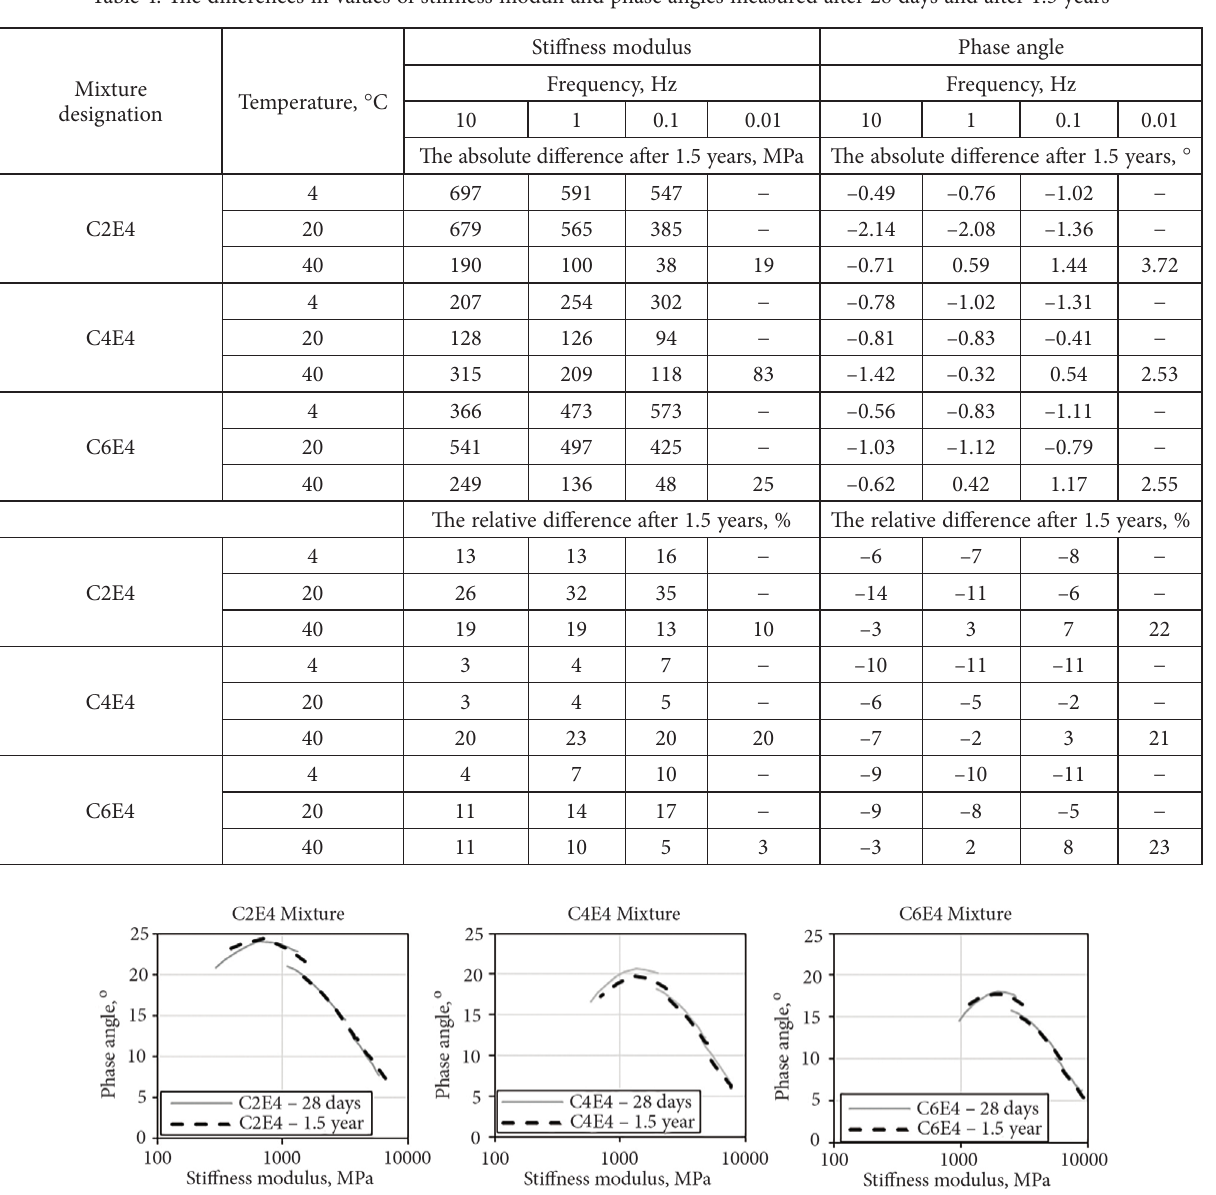
Figure 3. Black diagrams for selected Mineral-Cement-Emulsion mixtures Table 4. The choice of representative mixtures was based